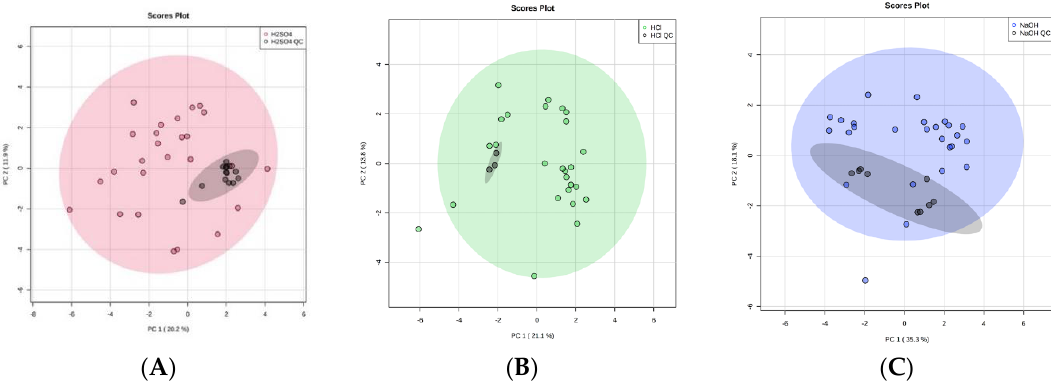
Figure 6. Principal component analysis (PCA) plots to illustrate equipment stability of the HS-SPME-GC-MS over time by comparing 1 mL ‘real’ urine samples with 1 mL QC technical replicates (black). With the addition of 0.2 mL of ( A ) 5 M H 2 SO 4 (red), ( B ) 5 M HCl (green), and ( C ) 5 M NaOH (blue). 95% confidence intervals are displayed by the shaded ellipses: ( A ) 5 M H 2 SO 4 (red), ( B ) 5 M HCl (green), and ( C ) 5 M NaOH (blue), and QC technical replicates (grey).